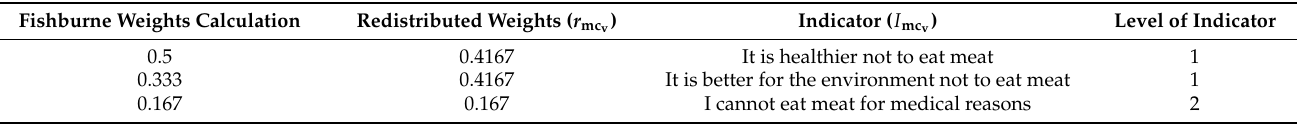
Table 8. Reasoning indicators for not consuming meat.